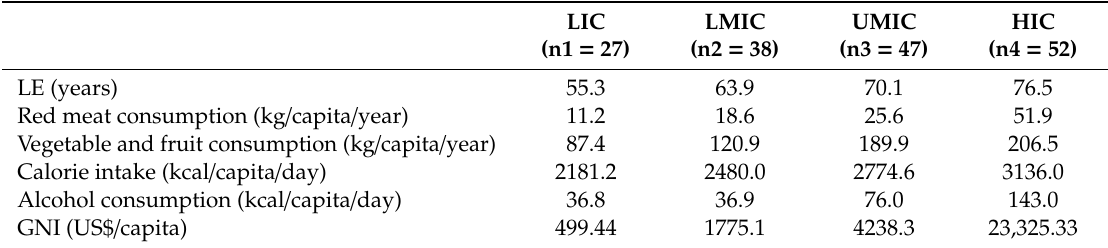
Table 2. Means of characteristics of 164 countries by income level over the period 1992 to 2013.